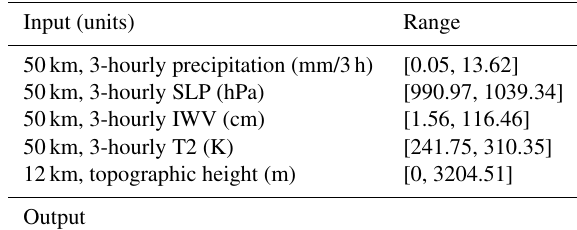
Table 1. Inputs and outputs for the new CNNs developed in this study. The range column shows the top and bottom 0.1% of the variable over the study domain for the time series of 3-hourly data in year 2005. All data are produced by the WRF model.